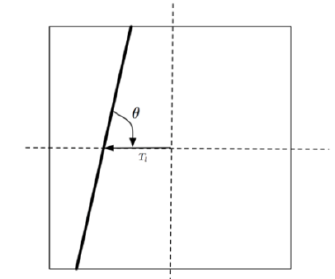
Figure 4. Variables obtained from the image plane for control perpose. 𝜃 is the angle with regards to the vertical and 𝑇 distance to the image center